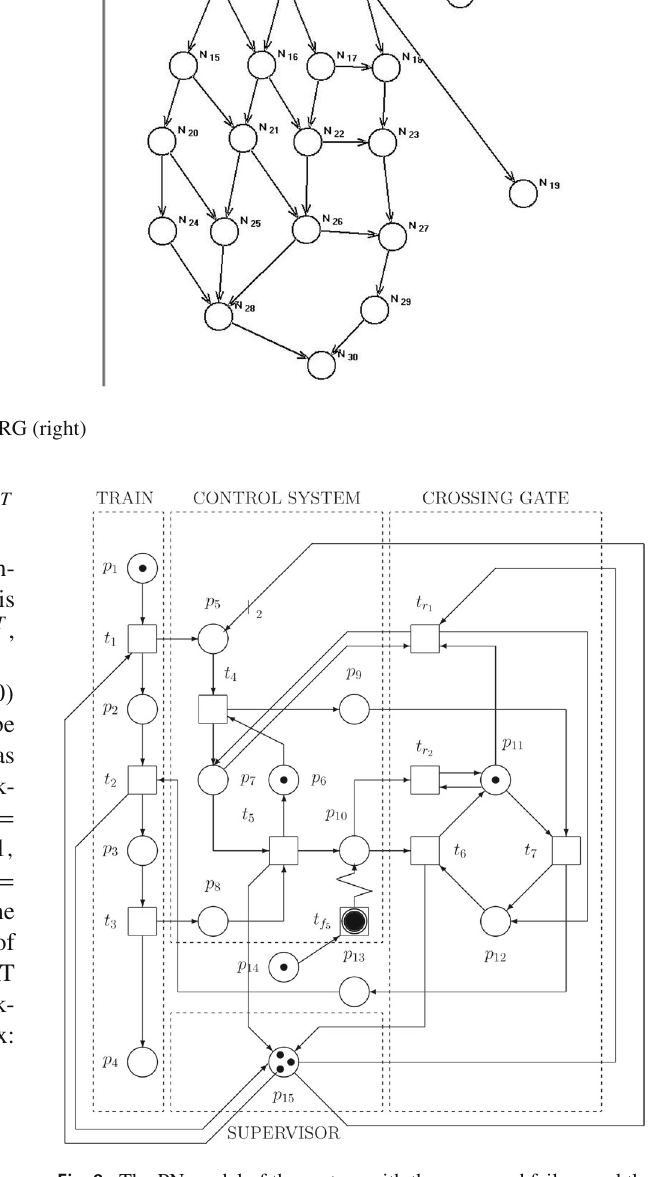
Fig. 8 The PN model of the system with the recovered failure and the deadlock removed by means of the